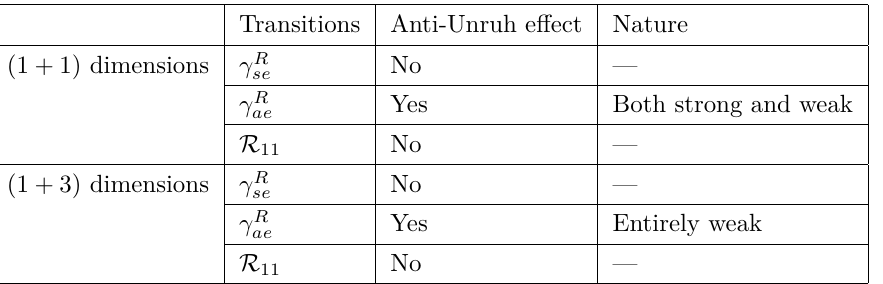
Table 2 . The case with the Rindler